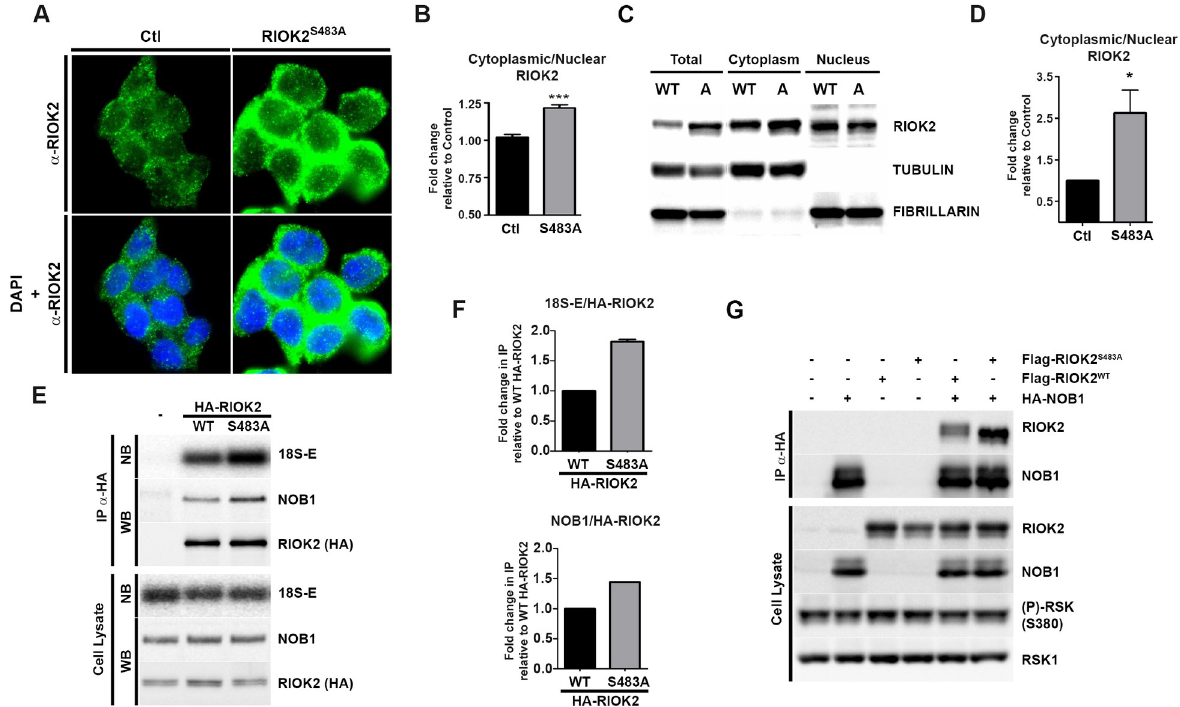
Fig 5. Loss of RIOK2 phosphorylation at Ser483 increases its association with cytoplasmic pre-40S particles. (A) RIOK2 localization was analyzed by IF microscopy using anti-RIOK2 antibodies in RIOK2 WT (Ctl) and RIOK2 S483A eHAP1 cell lines. Nuclei were visualized by DAPI staining. (B) Quantification of fluorescence observed in (A) using ImageJ software, as described in S7 Fig, and expressed as fold change relative to Ctl (n = 100 cells from different fields). Statistically significant differences are indicated by asterisks ( ��� : P < 0.0001, One-tailed Mann Whitney test). (C) Nucleo-cytoplasmic fractionation of serum-growing RIOK2 WT (Ctl) and RIOK2 S483A eHAP1 cell lines. RIOK2 levels in the different fractions (total cell extract, cytoplasm, nucleus) were analyzed by WB. Fractionation quality was validated using antibodies detecting tubulin (cytoplasmic protein) and fibrillarin (nuclear protein). (D) WB signals obtained in the cytoplasmic and nuclear fractions from (C) were quantified. The graph represents cytoplasmic/nuclear intensity ratios. Statistically significant differences are indicated by asterisks ( � : P � 0.05, One-tailed Mann Whitney test). (E) HEK293 cells were transfected with plasmids expressing HA-tagged RIOK2 WT or RIOK2 S483A , or with empty vector (-). HA-RIOK2 was immunoprecipitated and co-immunoprecipitated proteins and 18S-E pre-rRNA were analyzed by WB and NB, respectively. (F) Quantification of the WB and NB signals obtained in (E) expressed as fold change compared to immunoprecipitated HA-RIOK2 WT . (G) HEK293 cells were co- transfected with plasmids expressing HA-NOB1 and either Flag-RIOK2 WT or Flag-RIOK2 S483A . HA-NOB1 was immunoprecipitated and the co- immunoprecipitated proteins were analyzed by